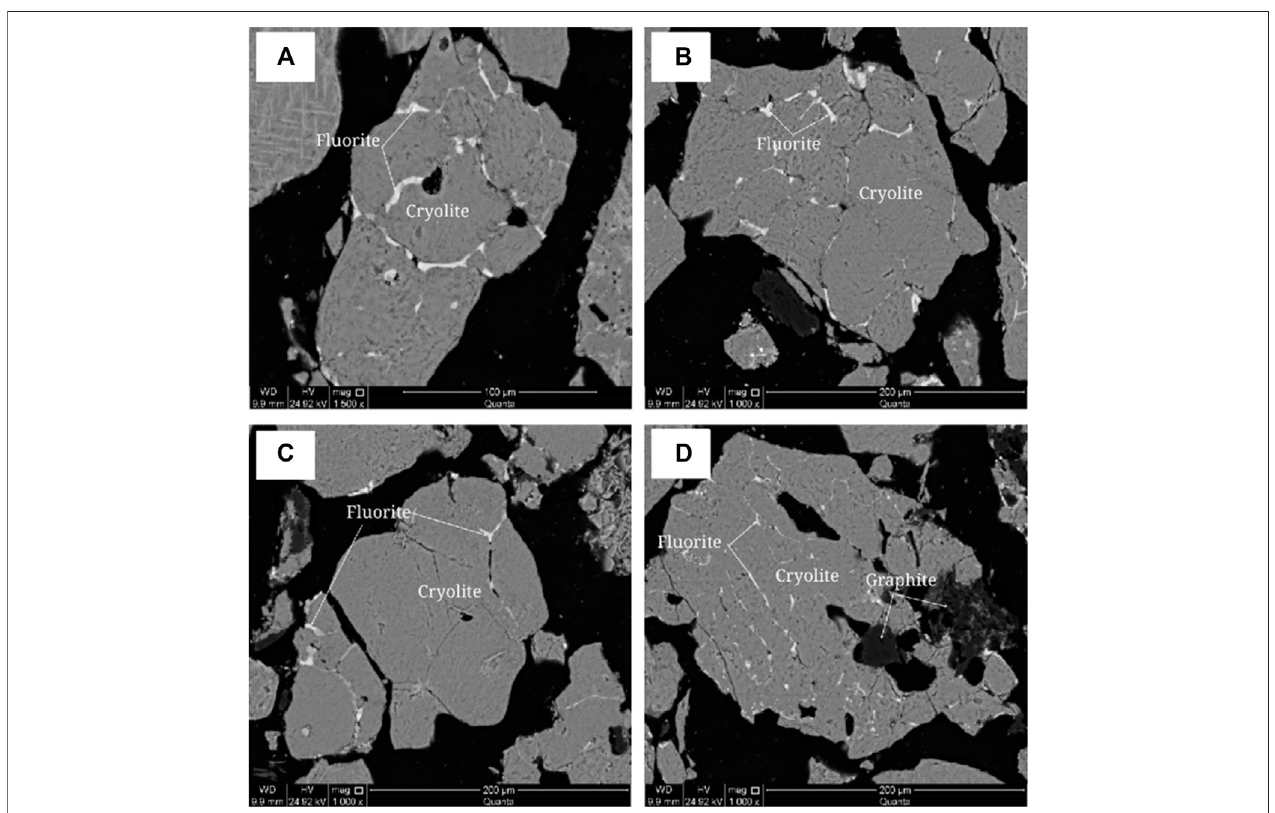
FIGURE 11 | Scanning electron microscope backscattered electron image of fl uorite. (A) Fluorite aggregates are veined between cryolite grains; (B) Fluorite aggregates are veined between cryolite grains; (C) Fluorite aggregates are distributed between cryolite grains; (D) Fluorite aggregates are veined in cryolite.